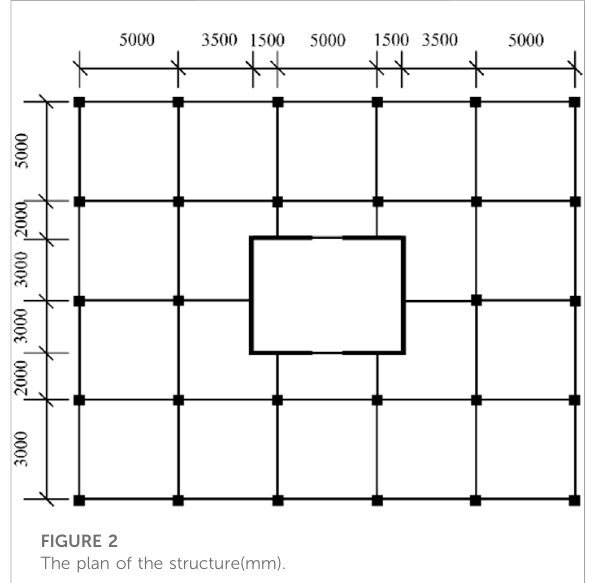
FIGURE 2 The plan of the structure(mm).